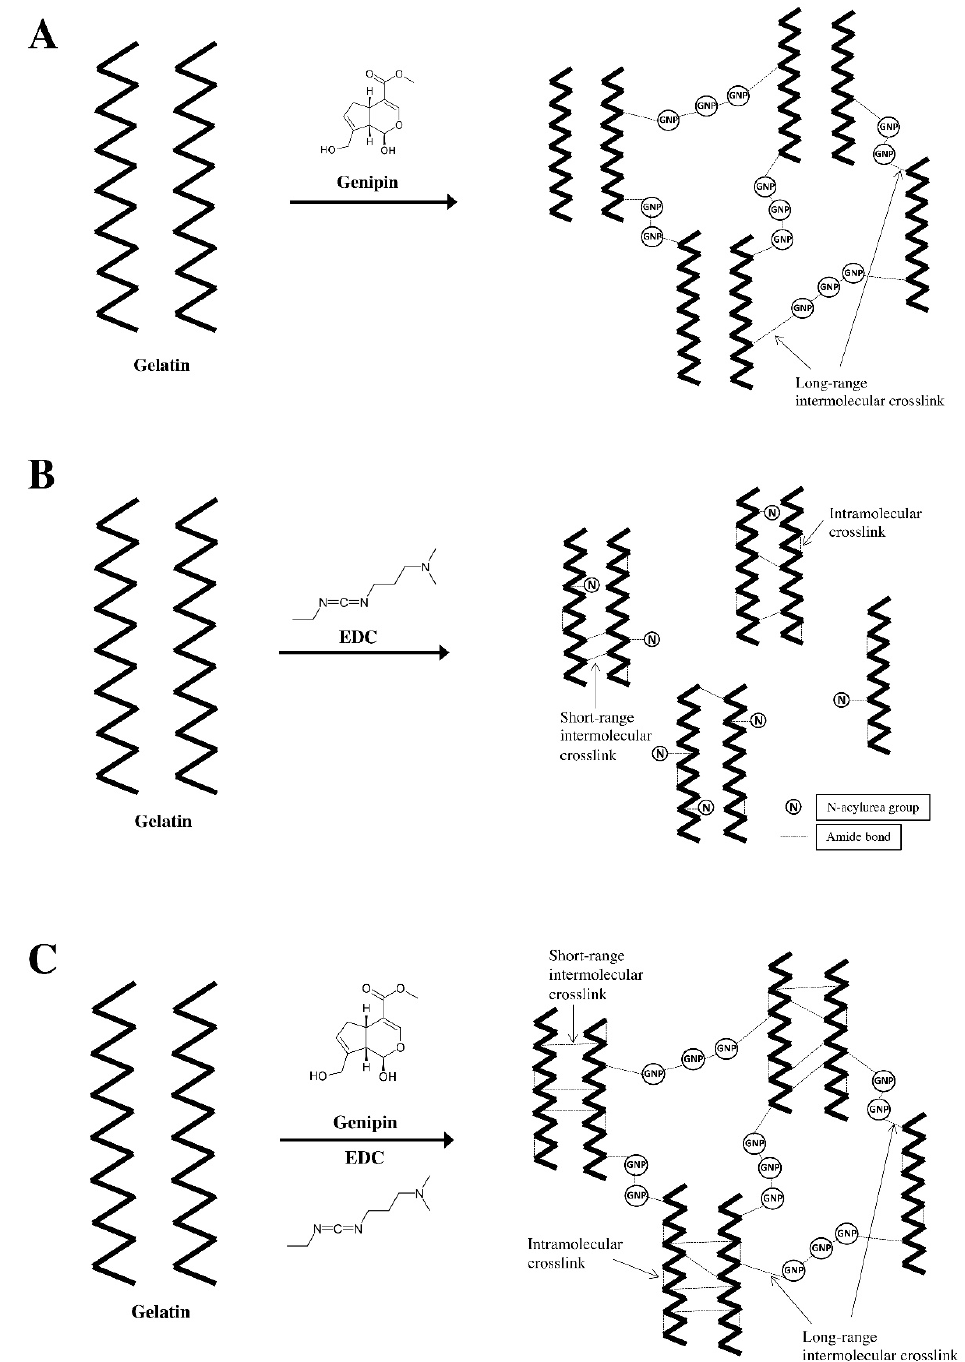
Figure 1. Crosslinking structure of ( A ) gelatin with genipin, ( B ) gelatin with EDC and ( C ) gelatin with double crosslinking of genipin and EDC.